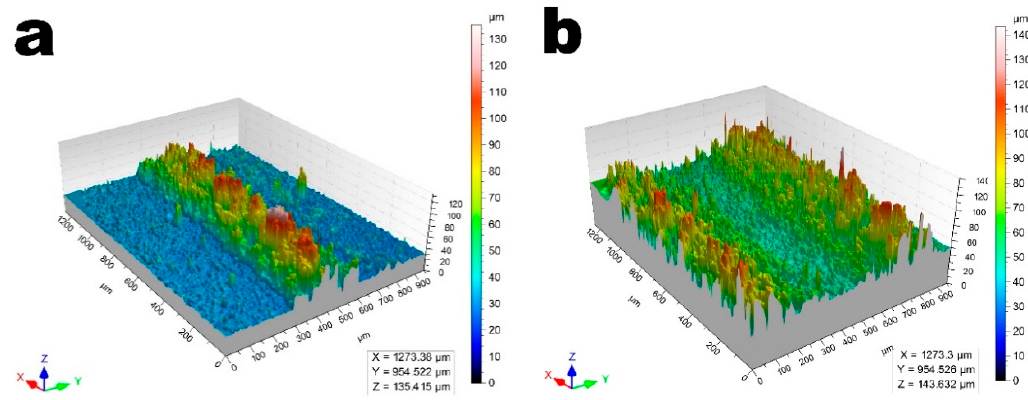
Figure 8. Confocal microscopy images show: ( a ) the formed microarrays in a non-linear cone shape and ( b ) pitch between cones. These features were caused by dynamic templating of hydrogen bubbles during electrodeposition of magnesium laurate.